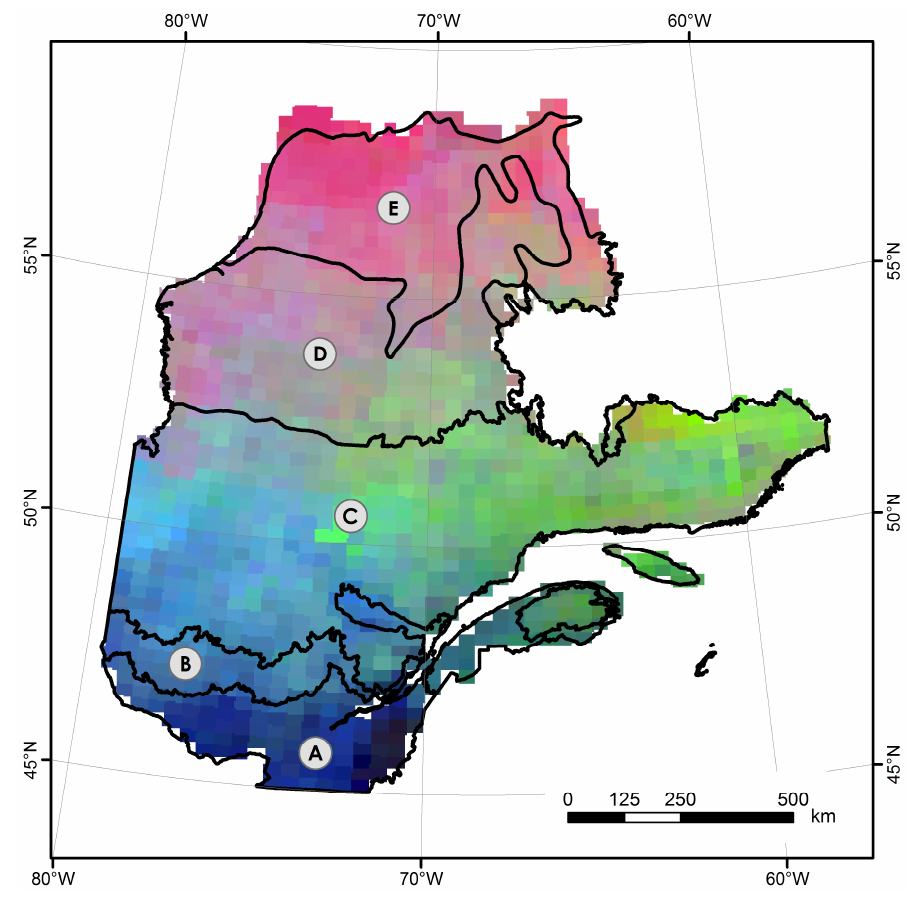
Figure 2. Composite image comprised of the three first principal components of landscape metric values (PC1 in red, PC2 in green, PC3 in blue). Each square cell represents an individual